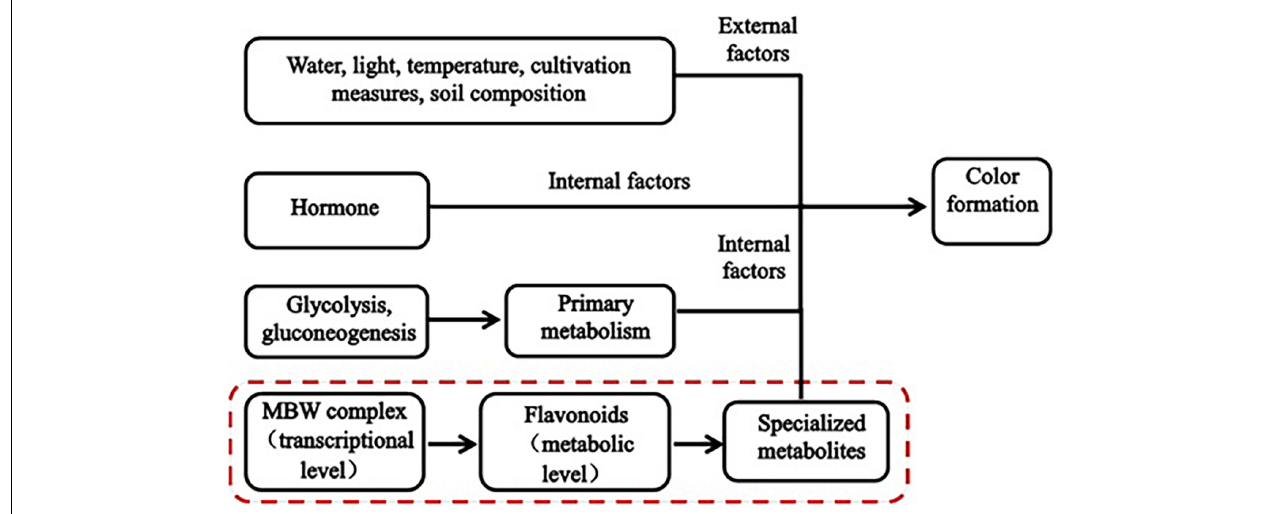
FIGURE 1 | Mechanism underlying plant color